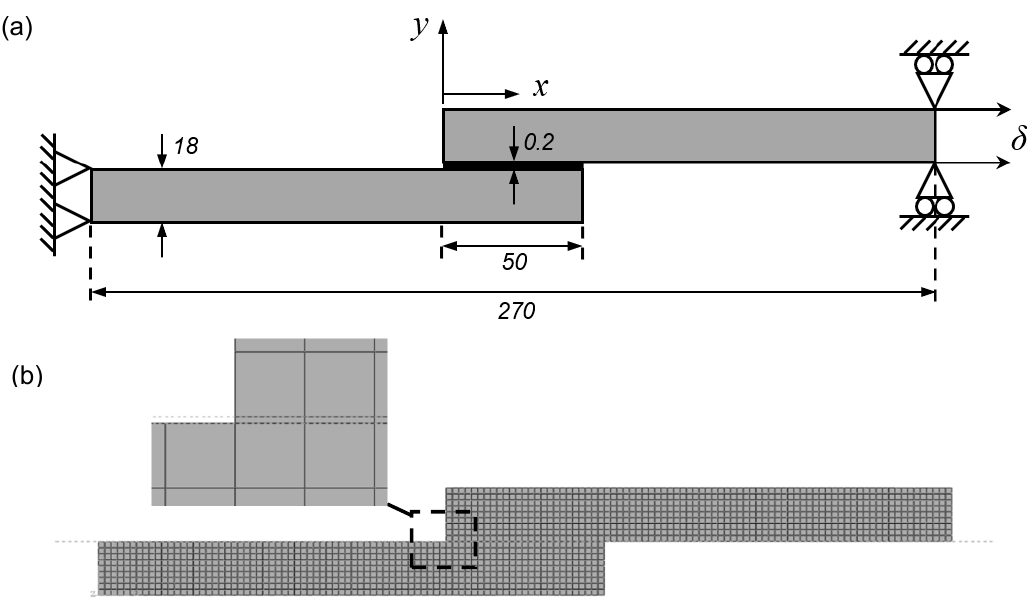
Figure 3. ( a ) Geometry and boundary conditions and ( b ) mesh detail for the single lap-shear adhesive joint (dimensions in mm).